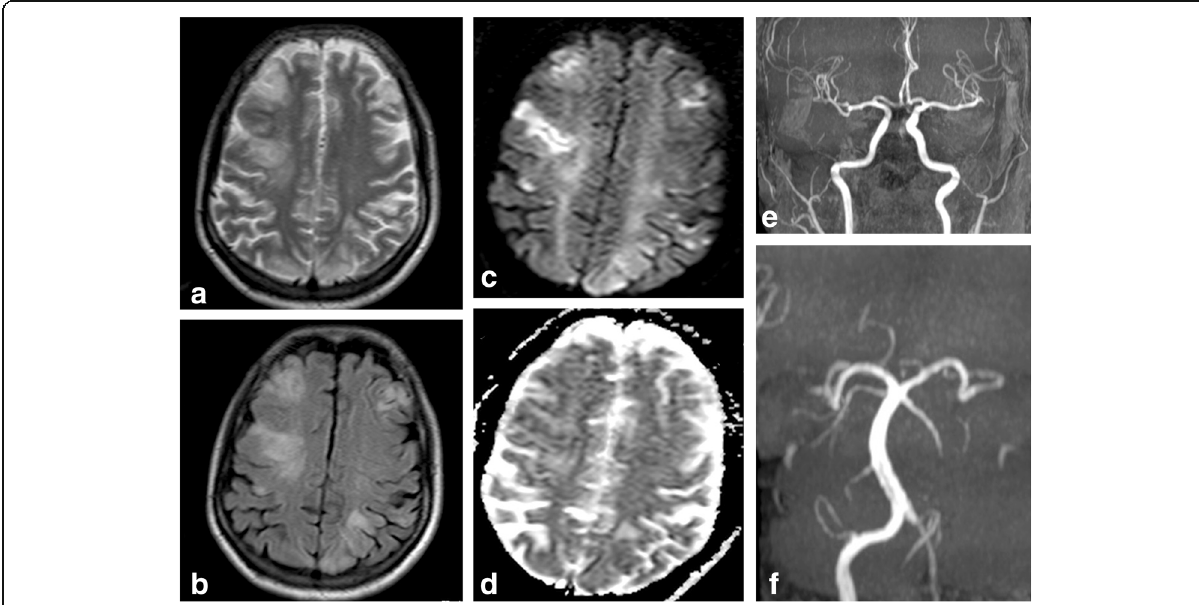
Fig. 1 MRI and MRA of the brain. a , b Axial T2 and FLAIR WIs demonstrate bilateral, cerebral, multifocal cortical, and subcortical areas of high signal intensity. c , d Axial diffusion WIs and ADC map at the same level showing no evidence of restricted diffusion. e , f MRA images showing normal appearance of the anterior and posterior circulation major